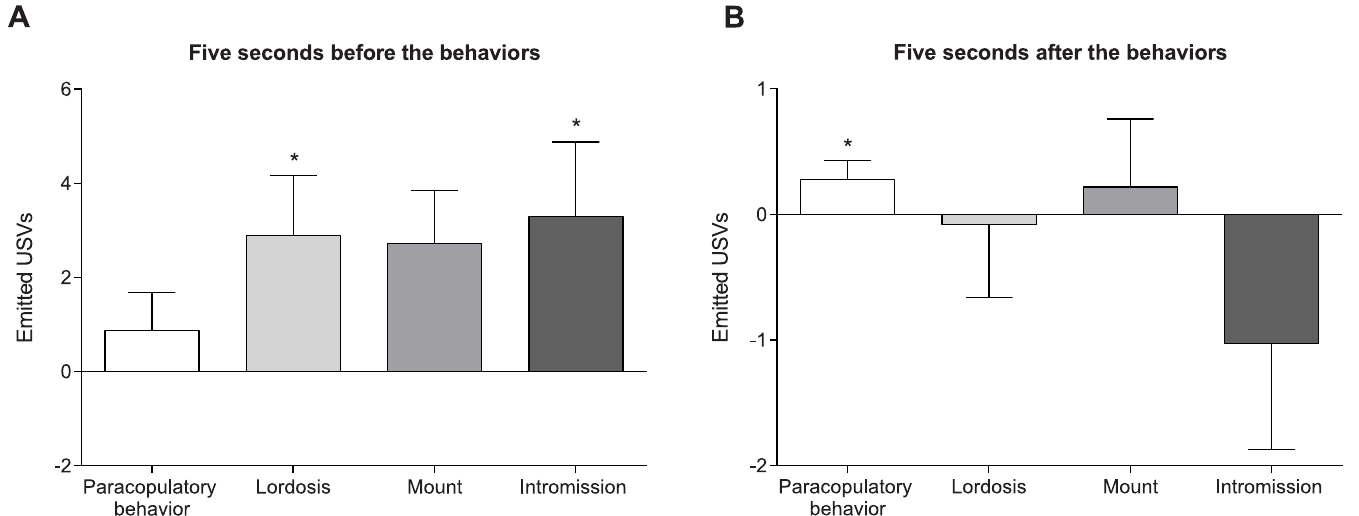
Fig 4. Increased emission of male USVs before an intromission or lordosis. (A) The average number of ultrasonic vocalizations (USVs) emitted by male rats (paired with devocalized females) during the five seconds before, and (B) the five seconds after a mount, intromission, lordosis, or paracopulatory behavior. Both graphs show the comparison between USVs emitted before or after the behaviors minus the USVs that would have been emitted during 5 seconds in the equally distributed USVs ( * p < 0.05 compared to zero). Data are shown as median ± semi interquartile range.